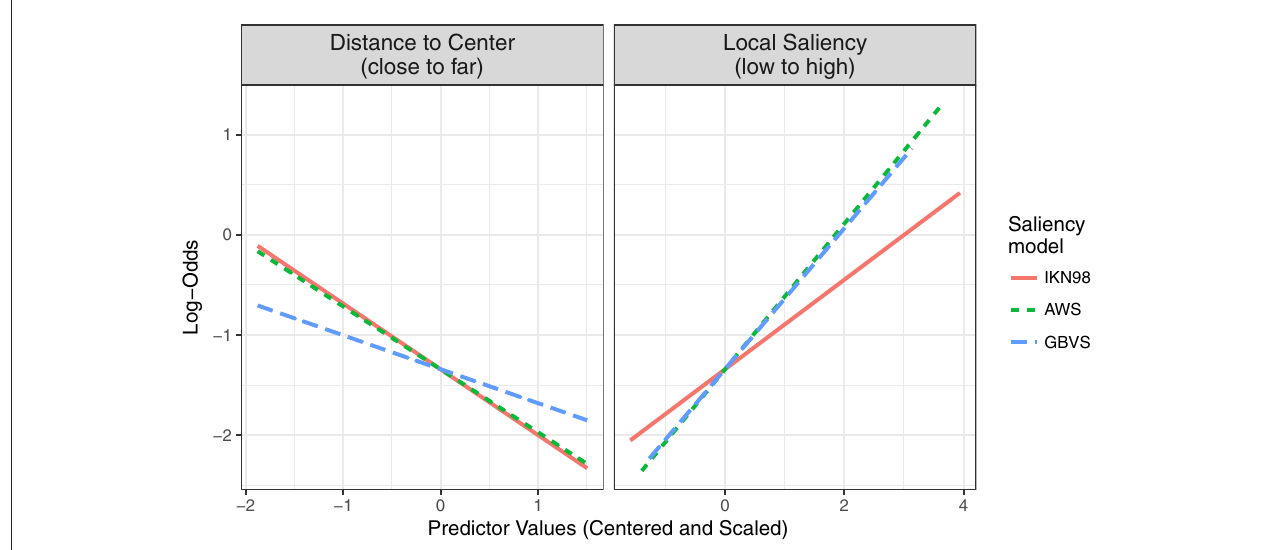
FIGURE 9 | Central-Bias—Saliency Comparison GLMM. The figure visualizes predicted partial effects of central bias (left) and image saliency (right) on fixation probabilityinlog-oddsscaleforthreesaliencymodelsthatwereincludedinthecomparison(IKN98,redsolidline;AWS,greendashedline;GBVS,bluelong-dashedline).